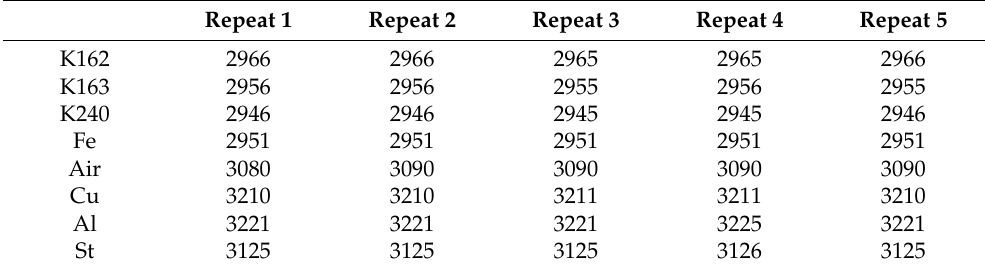
Table 3. The quantization index of the model was verified repeatedly with 100 random samples per